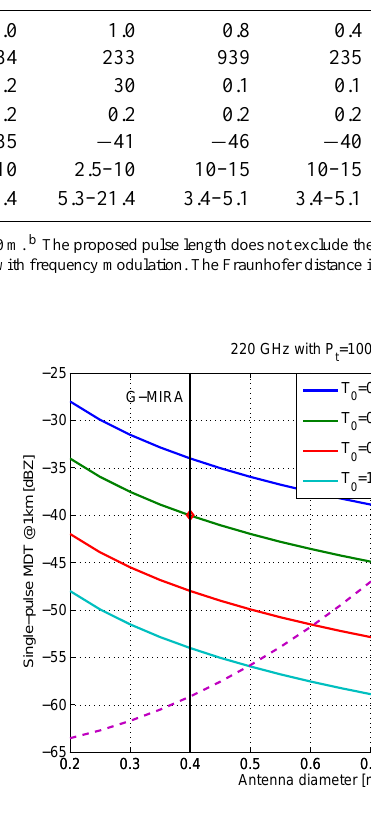
Fig.16. MDT (lefty-scale)andFraunhoferdistance(righty-scale)asafunctionoftheantennadiameterand Figure 16. MDT (left y scale) and Fraunhofer distance (right y fordifferentpulselengths T 0 . Theassumedtransmittedpoweris100 W . Anoisefigureof6.5 dB isassumed. scale) as a function of the antenna diameter and for different pulse lengths T 0 . The assumed transmitted power is 100W. A noise figure of 6.5dB is